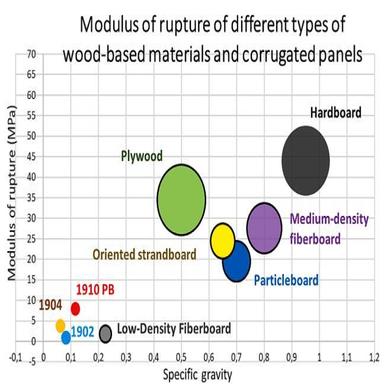
Modulus flexural failure of different types of wood-based materials and corrugated panels.